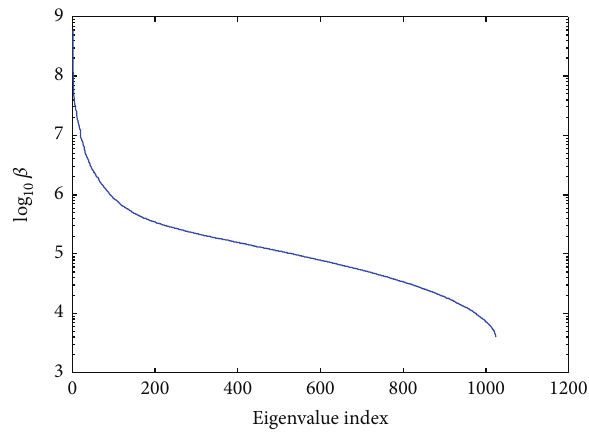
Figure 1: Size of eigenvalues versus their index for M7-300ff.dat image.